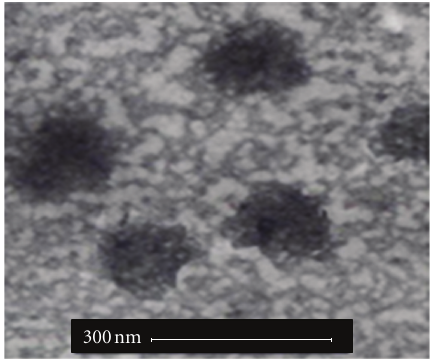
Figure 3: Transmission electron micrograph of the CY11-PEI- β - CyD/DNA polyplex. The polyplex is spherical with a diameter of about 200